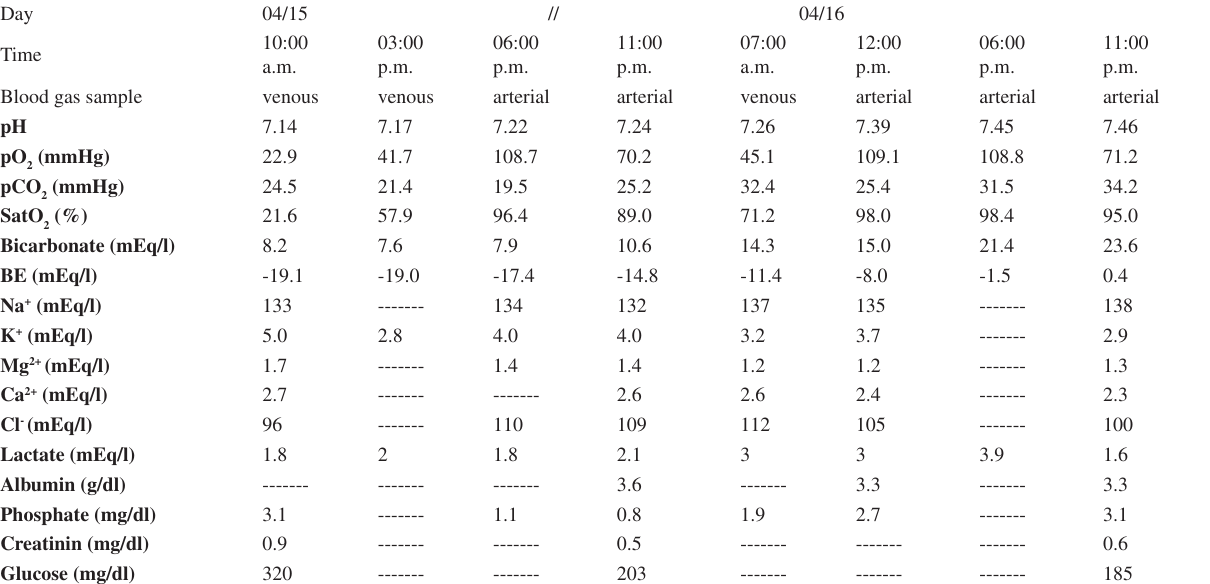
Table 2 - Traditional and Stewart acid-base variables during the course of diabetic ketoacidosis treatment